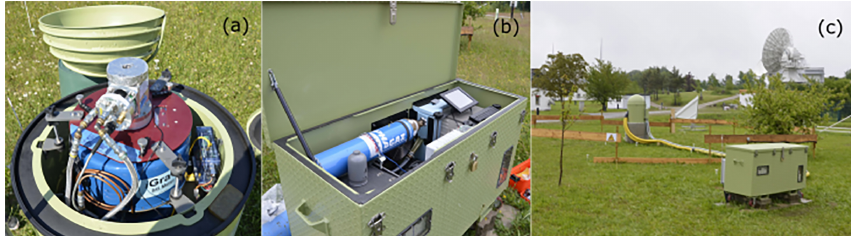
Figure 2. Photographs of the gravimeter monitoring system with (a) the iGrav inside the iGFE field enclosure, (b) peripheral hardware inside the iBox and (c) an overall view of iBox (foreground), dome-shaped iGFE and the yellow connection hoses. Photos were taken on a grassland site of the Geodetic Observatory Wettzell,